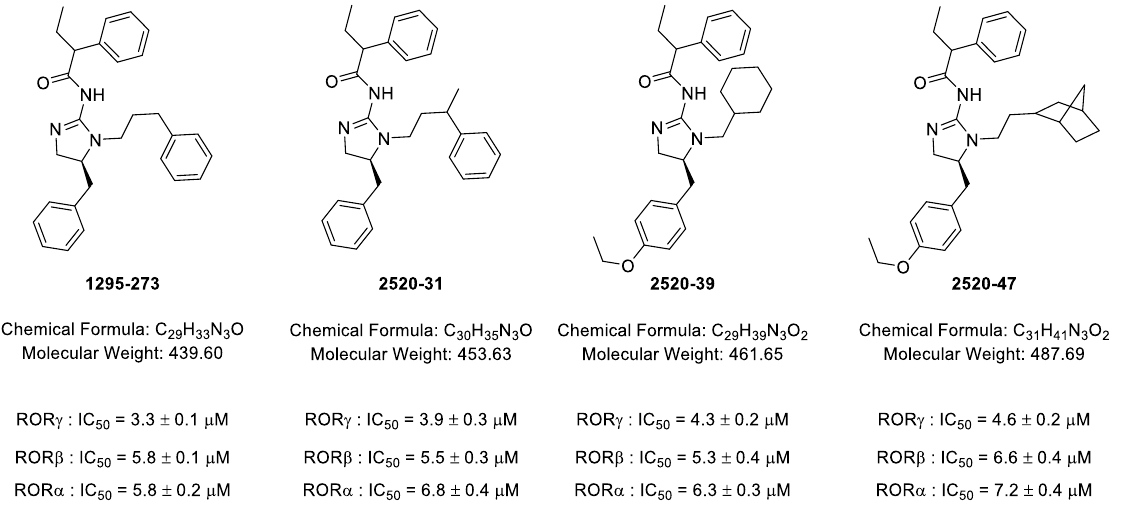
Figure 5 . Selected combinations of active mixtures with defined R 1 , R 2 , and R 3 . Figure 5. Selected combinations of active mixtures with defined R 1 , R 2 , and R 3 .